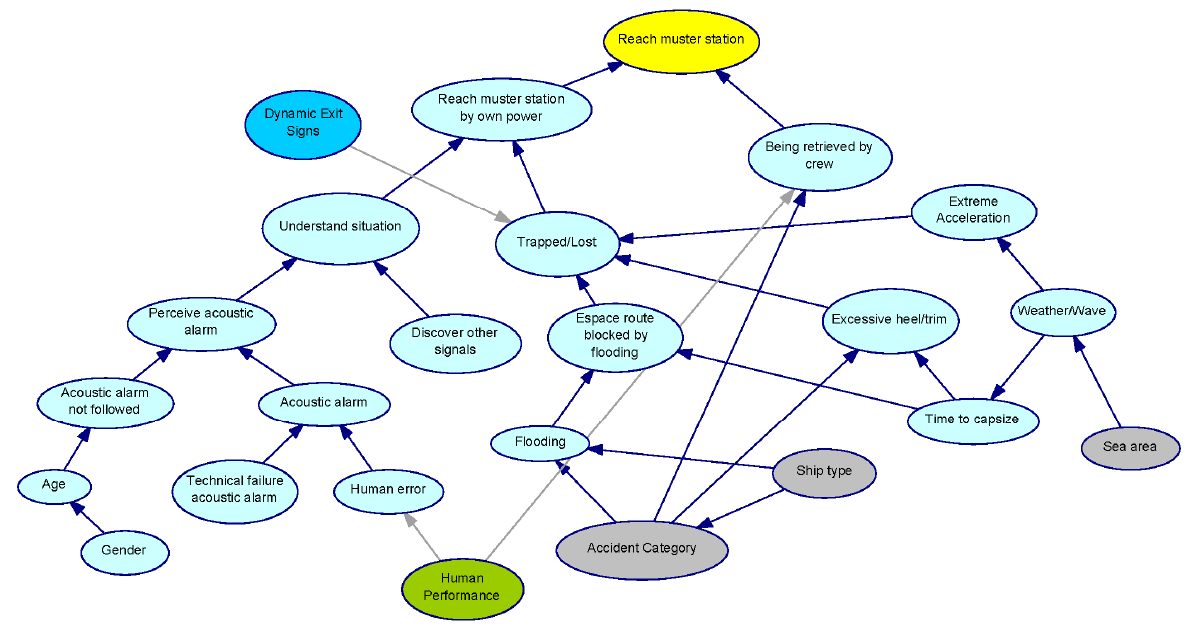
Figure 7. The Bayesian network for “Reaching Muster Station” in flooding accidents. Grey nodes: generic evidence (accident category = collision, ship type = cruise, and sea area = worldwide), blue nodes: RCO parameter (Dynamic Exit Signs), green nodes: qualitative parameter, yellow nodes: output parameter.